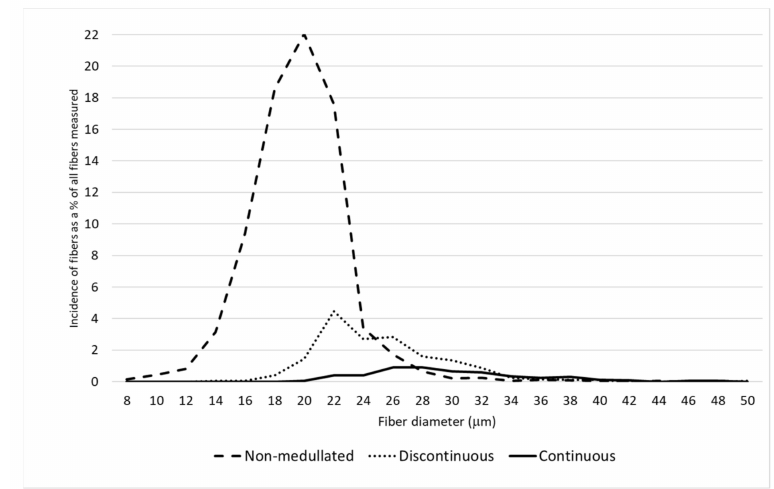
Figure 2. The distribution of each fiber category for the saddle.